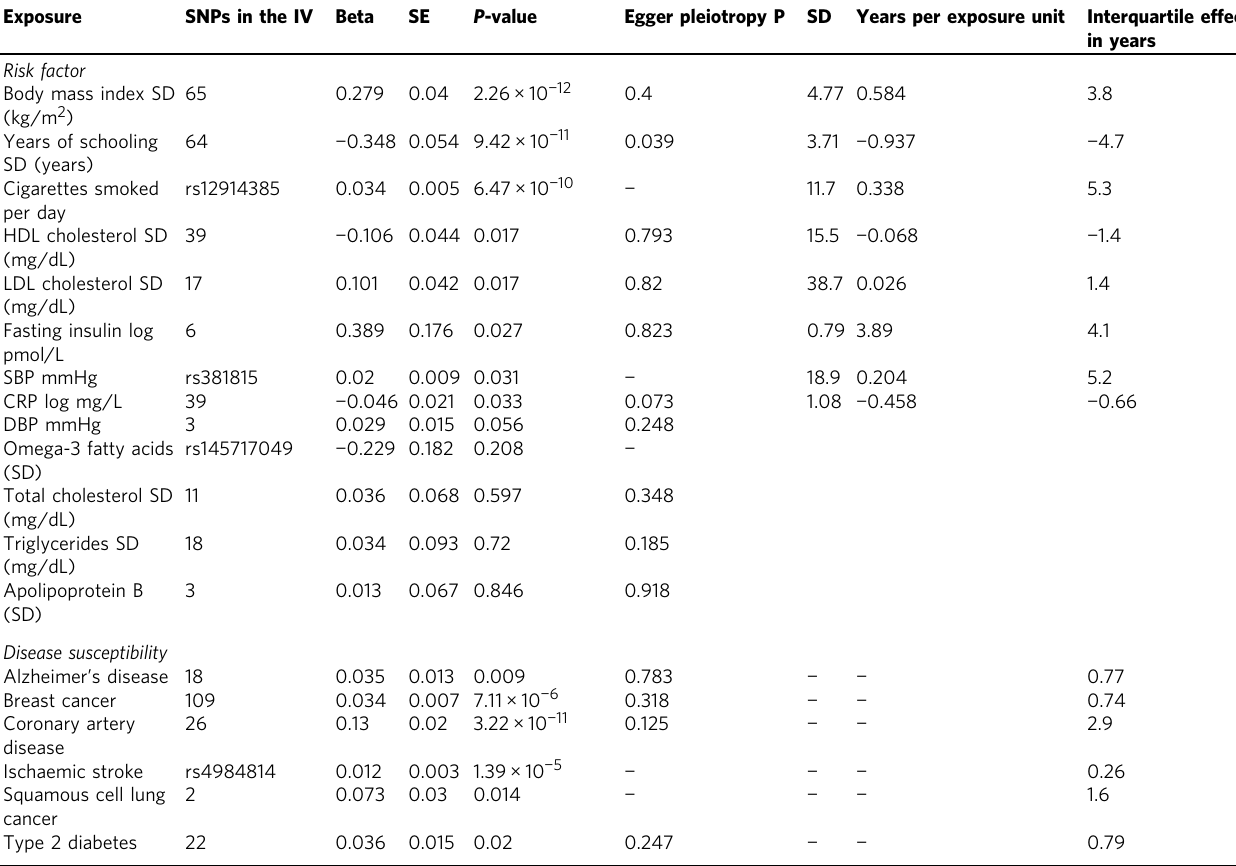
Table 3 Mendelian randomisation associations for the 19 traits with lifespan